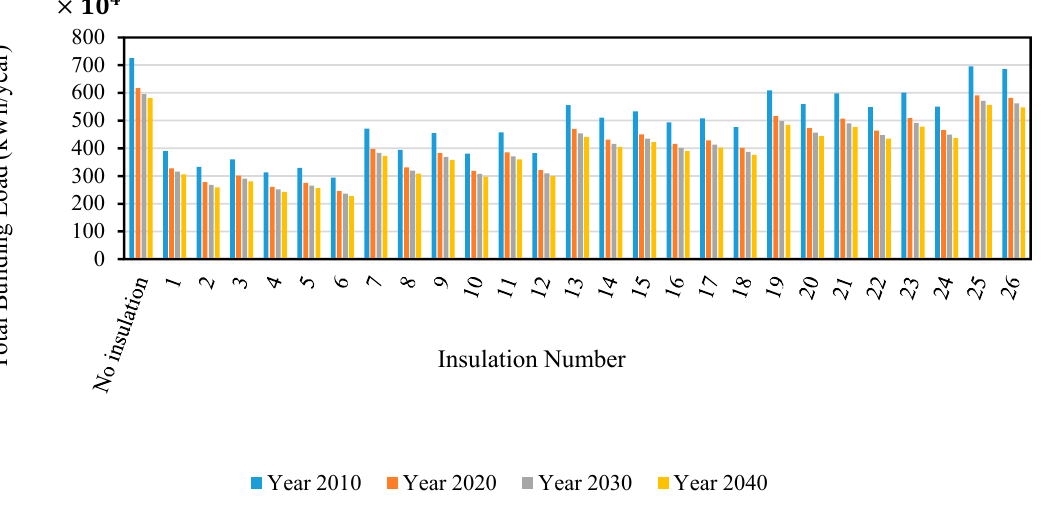
Figure 14. Comparison of the amount of total annual heating demand for different insulation types based on Table 5 for different years.